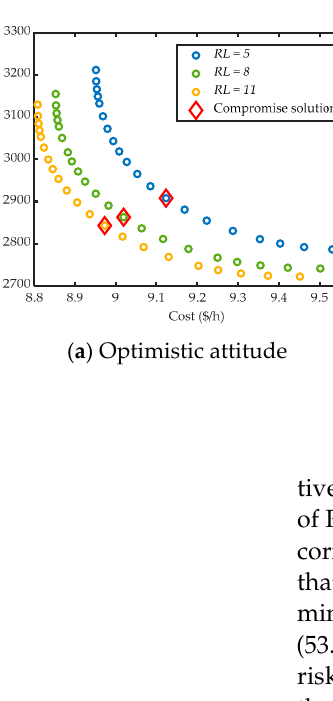
Figure 7. Pareto fronts in terms of dispatcher’s attitudes.